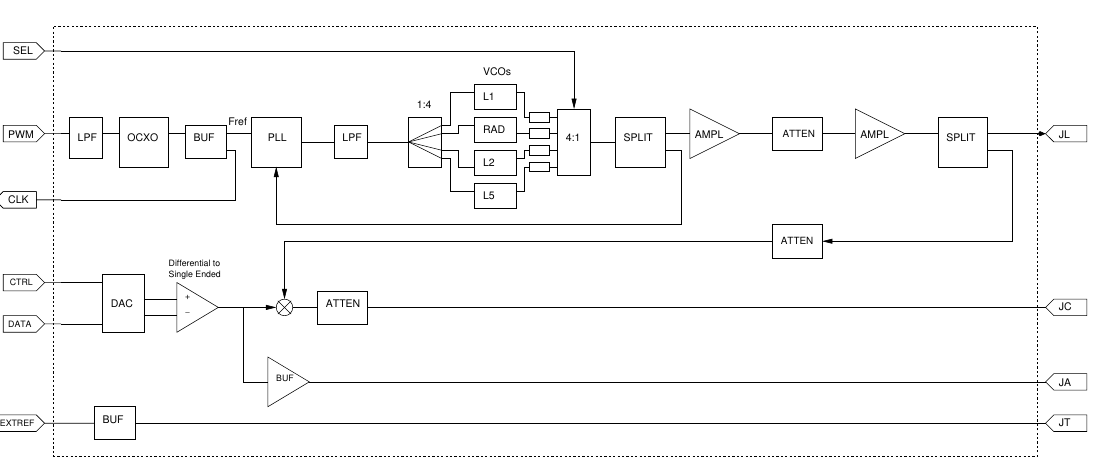
Figure 3. Block diagram of SPIR’s clock